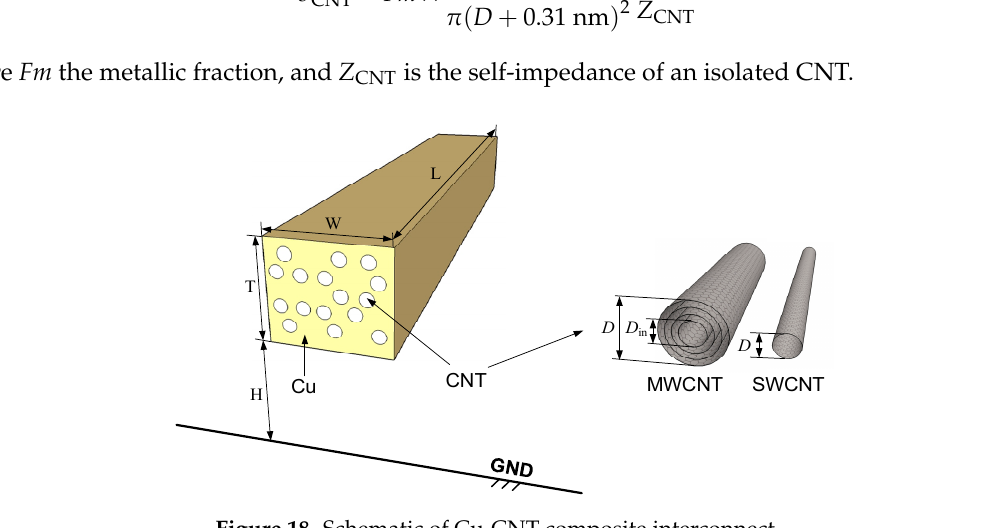
Figure 18. Schematic of Cu-CNT composite interconnect.